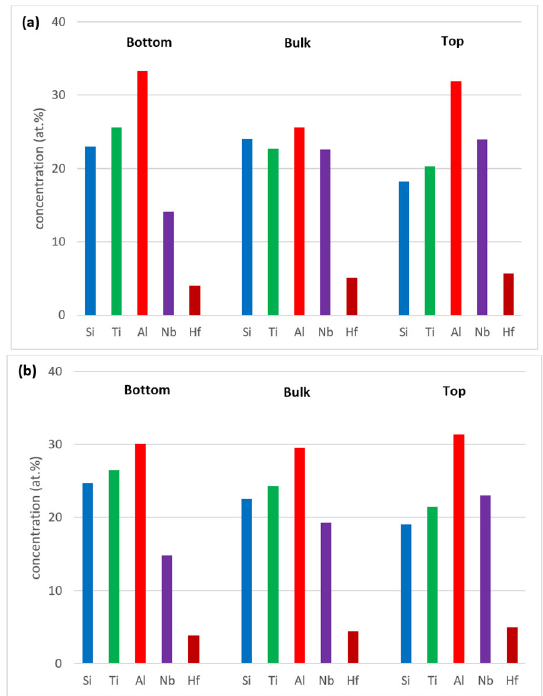
Figure 3. Comparison of the concentrations of elements in the bottom, bulk and top of the alloy Nb 1.7 Si 2.4 Ti 2.4 Al 3 Hf 0.5 ( a ) as cast; ( b ) heat treated at 1300 °C.